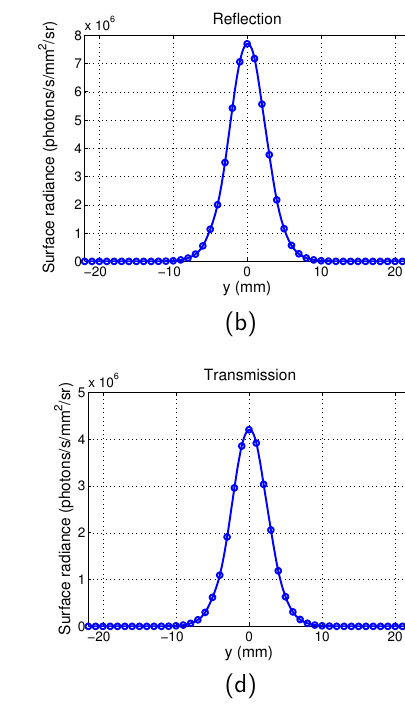
Figure A1. Point spread function for scanning imaging system. z = − 1mm, λ ex = 600nm, λ em = 1000nm. ( a ) Map for reflection mode; ( b ) surface radiance along y direction for x = 0mm for reflection mode; ( c ) map for transmission mode; and ( d ) surface radiance along y direction for x = 0mm for transmission mode.